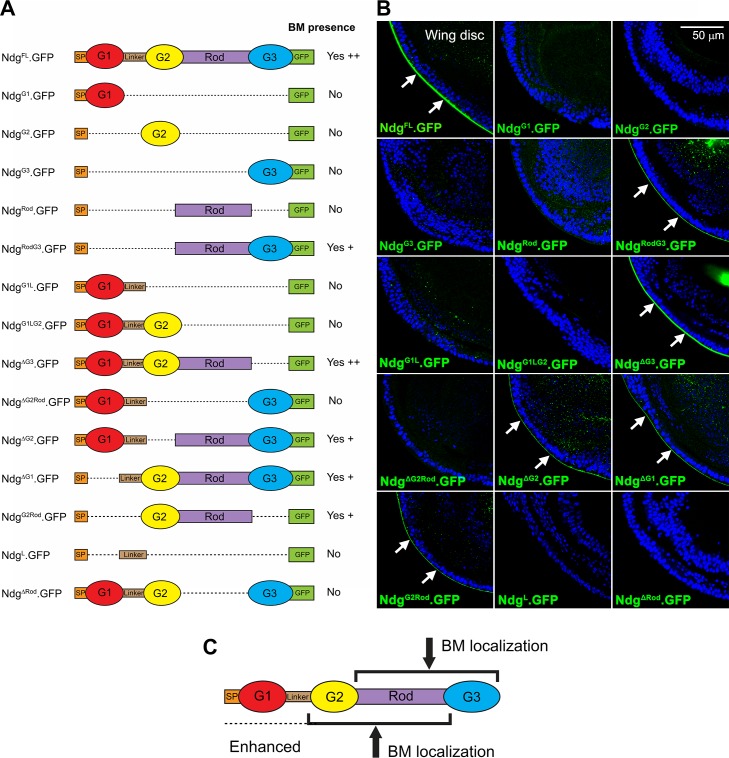
Rod domain is necessary but not sufficient for Nidogen localization to BMs.(A) Schematic depiction of Ndg full length (FL) and different Ndg deletions tested in this study. All Ndg versions are tagged with GFP in the C-terminal. SP = Signal Peptide. G1/2/3 = Globular domains 1/2/3. (B) Confocal images of wing discs from larvae expressing the indicated versions of Ndg under control of Cg-GAL4. Correct BM localization, detected by GFP signal (green, arrows), is observed only for Ndg versions containing the Rod domain (NdgFL, NdgRodG3, NdgΔG3, NdgΔG2, NdgΔG1 and NdgG2Rod) but neither NdgRod nor any other single domain can localize to the BM by itself. Nuclei stained with DAPI (blue). (C) Model of domain requirements for proper Ndg localization to BMs.